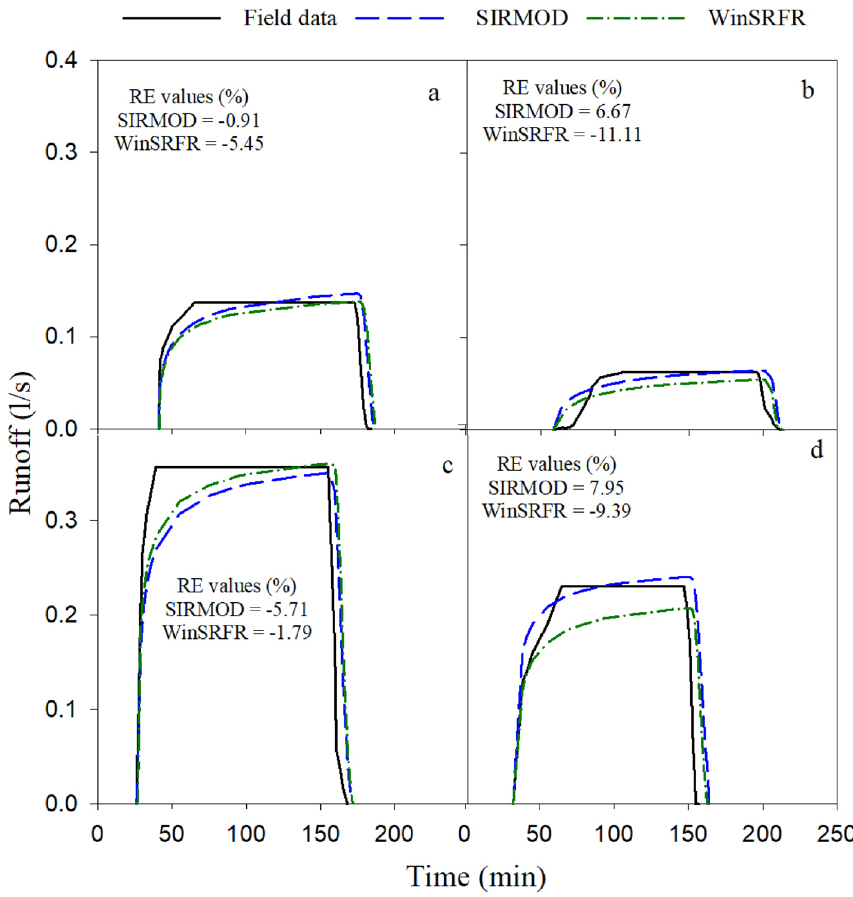
Figure 5. Comparison of the measured and simulated runoff under continuous irrigation ( a . Q 1 L 1 , b . Q 1 L 2 c . Q 2 L 1 and d . Q 2 L 2